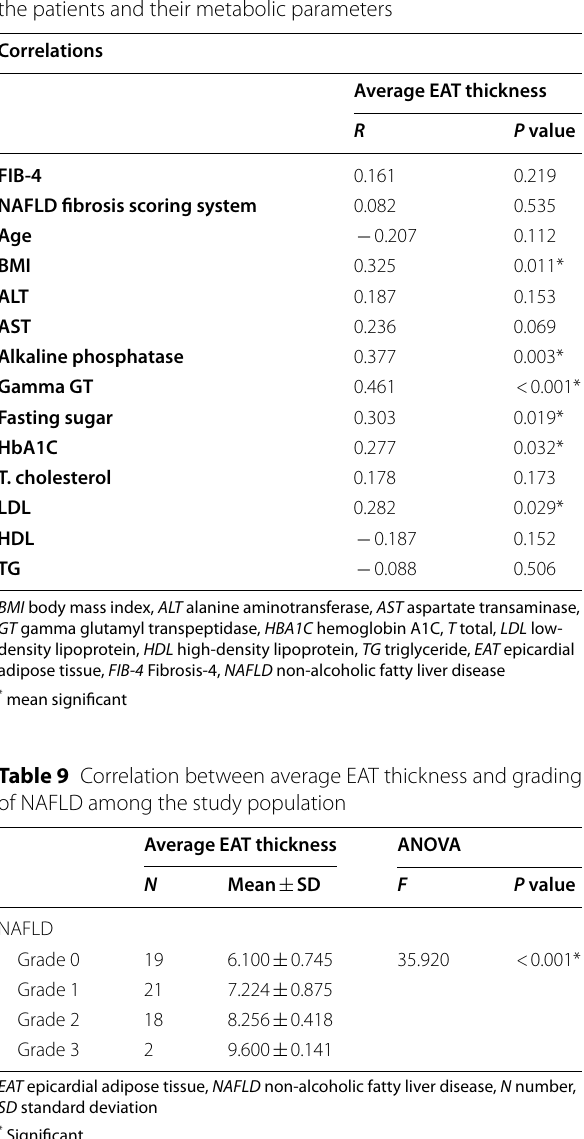
Table 10 ROC curve of EAT thickness in prediction of significant coronary artery disease (above 50% stenosis) ROC curve between group A and group B Cutoff